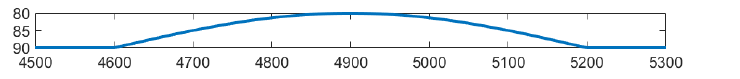
Figure 4. The bottom relief profile of the waveguide (the case of a seamount). Figure 5a,b were created for this